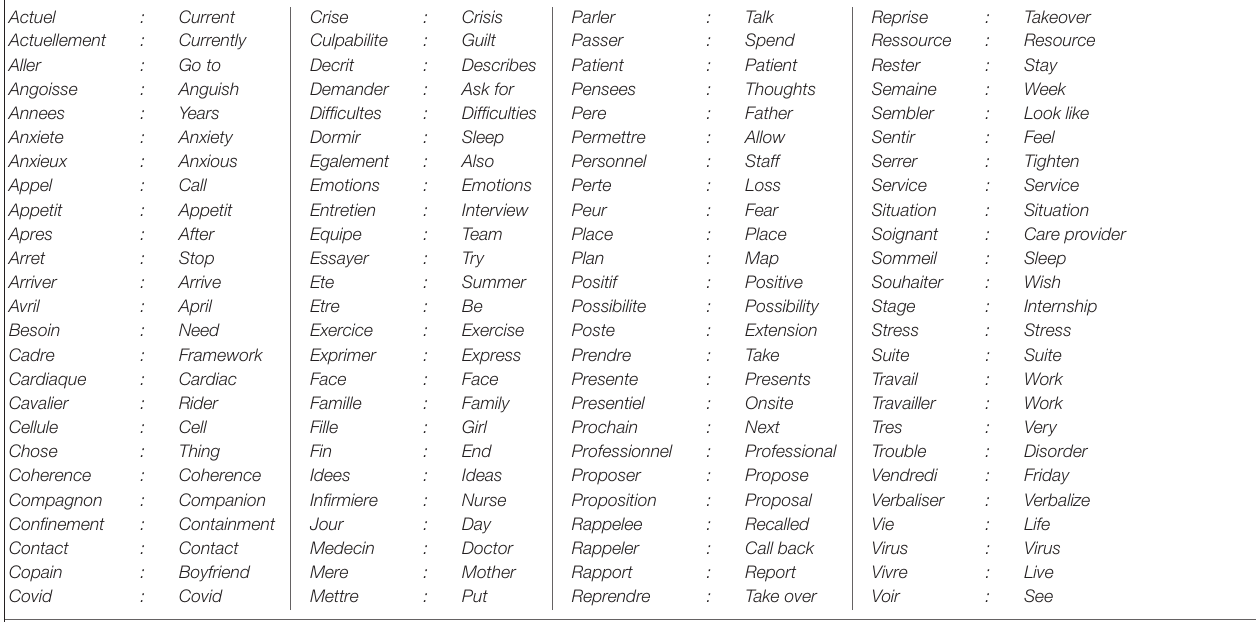
Frontiers in Psychiatry |